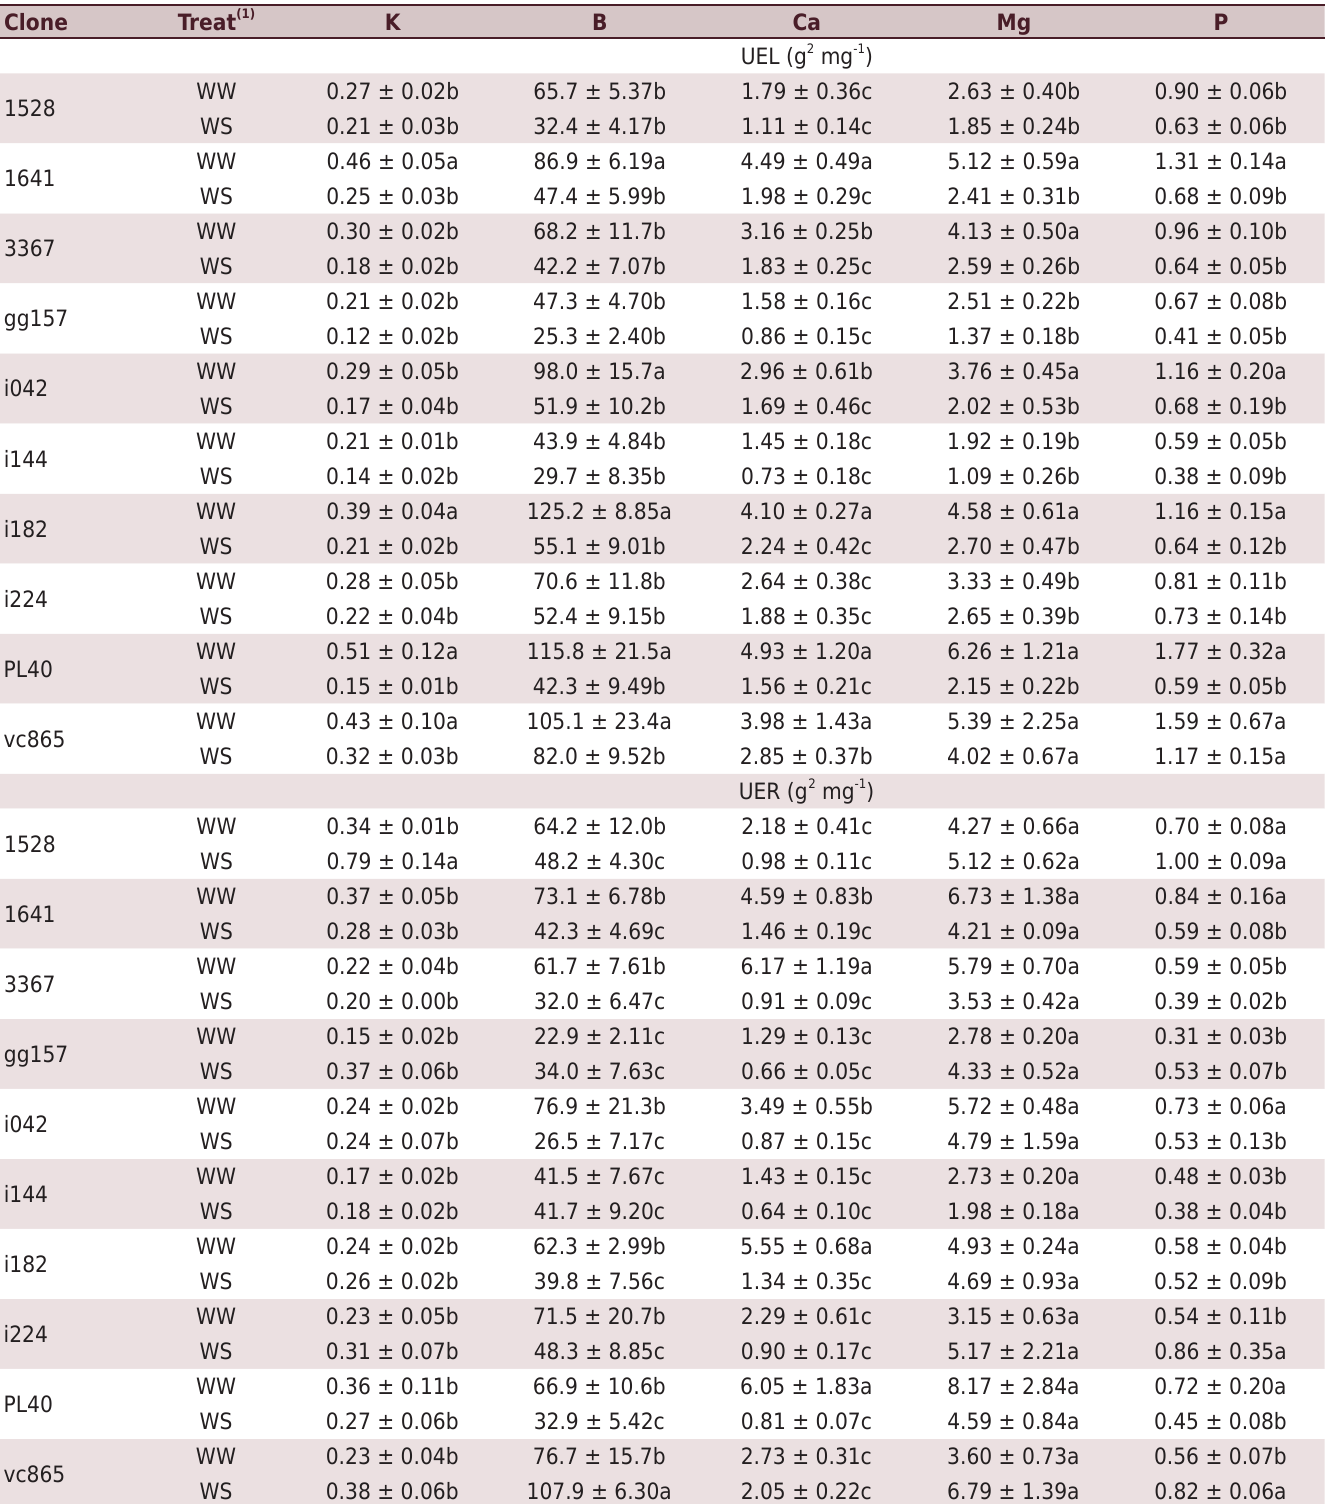
Table 3. Efficiency of nutrient use of leaf (UEL) and root production (UER) in ten Eucalyptus clones under well-watered (WW) or water stress (WS) conditions. Data indicate the mean ± SE (n =4). Means followed by the same letter in a column did not differ significantly by the Scott Knott test (p ≥